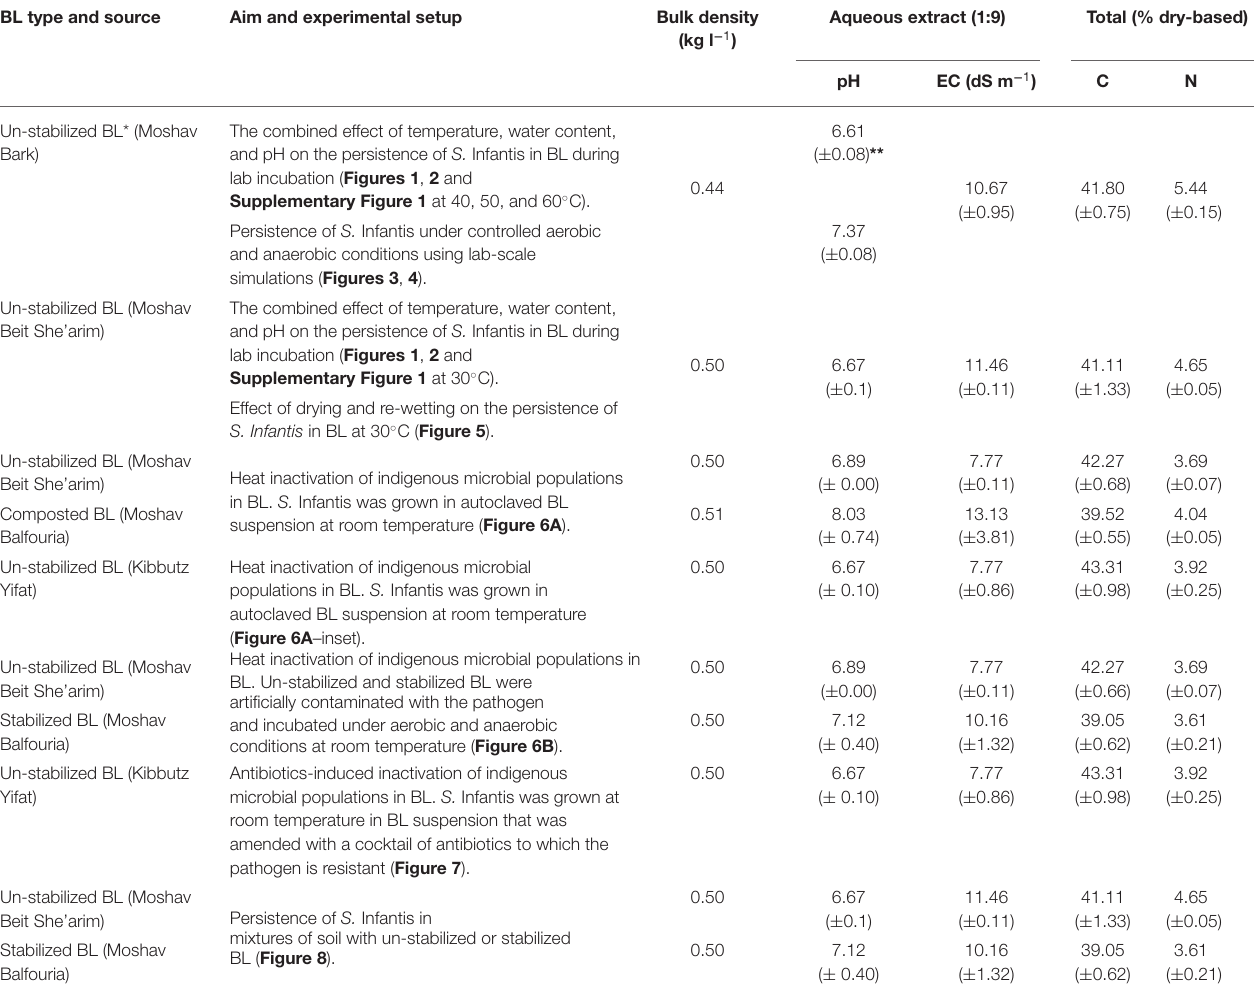
TABLE 1A | Selected properties of broiler litter (BL) and